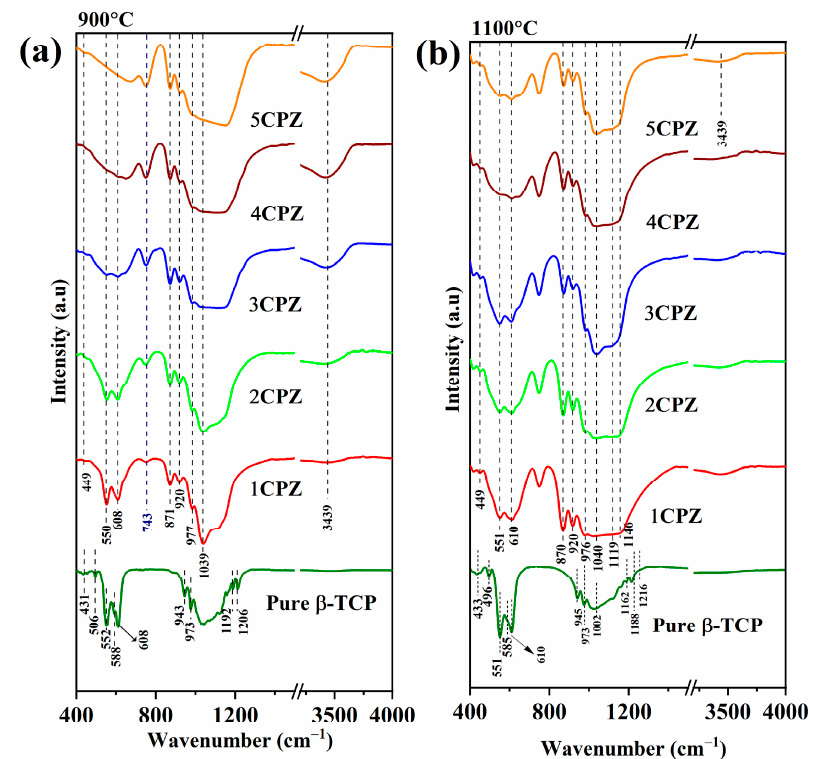
Figure 4. FT-IR spectra of the β -Ca 3 (PO 4 ) 2 –ZrO 2 composites after heat treatment at ( a ) 900 °C and ( b ) 1100 °C .